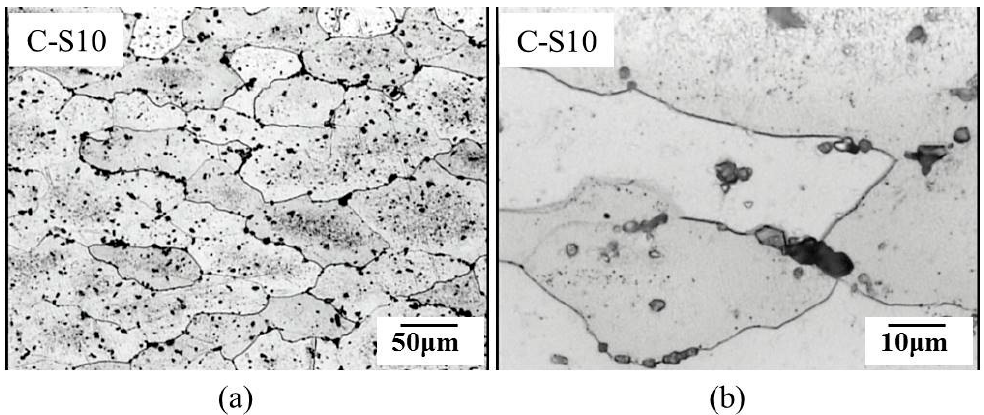
Figure 8. Microstructure of TS ‐ SIMA alloy at ( a ) small and ( b ) large magnification.